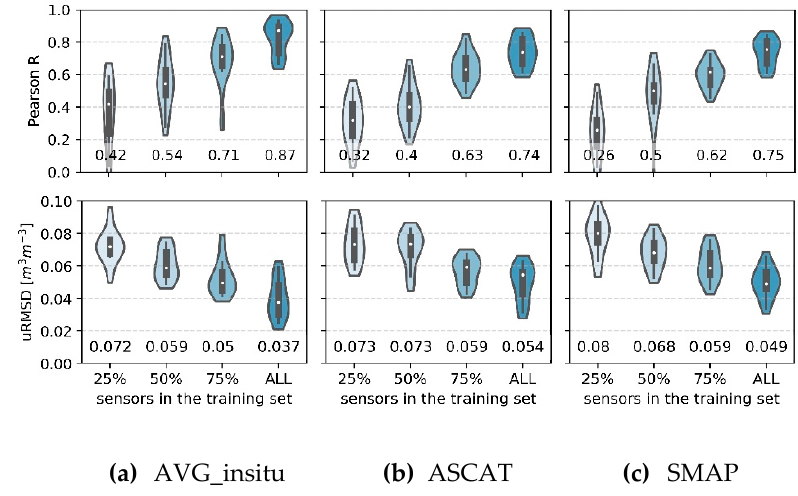
Figure 10. Violin plots of Pearson R (top) and uRMSD (bottom) between measured and predicted soil moisture (SSM + S + T + V) against the number of sensors used to train the models. Training sets consisted of 25%, 50%, and 75% of all available sensors (38), each sensor covering the same time interval of the original training set. For each training set size, we repeated the evaluation for 10 random permutations. The SSM source used is displayed above each graph. The boxplots within the violins indicate quartiles and the white dots depict the median values (also reported below the violins). ( a ) AVG_insitu, ( b ) ASCAT, ( c ) SMAP